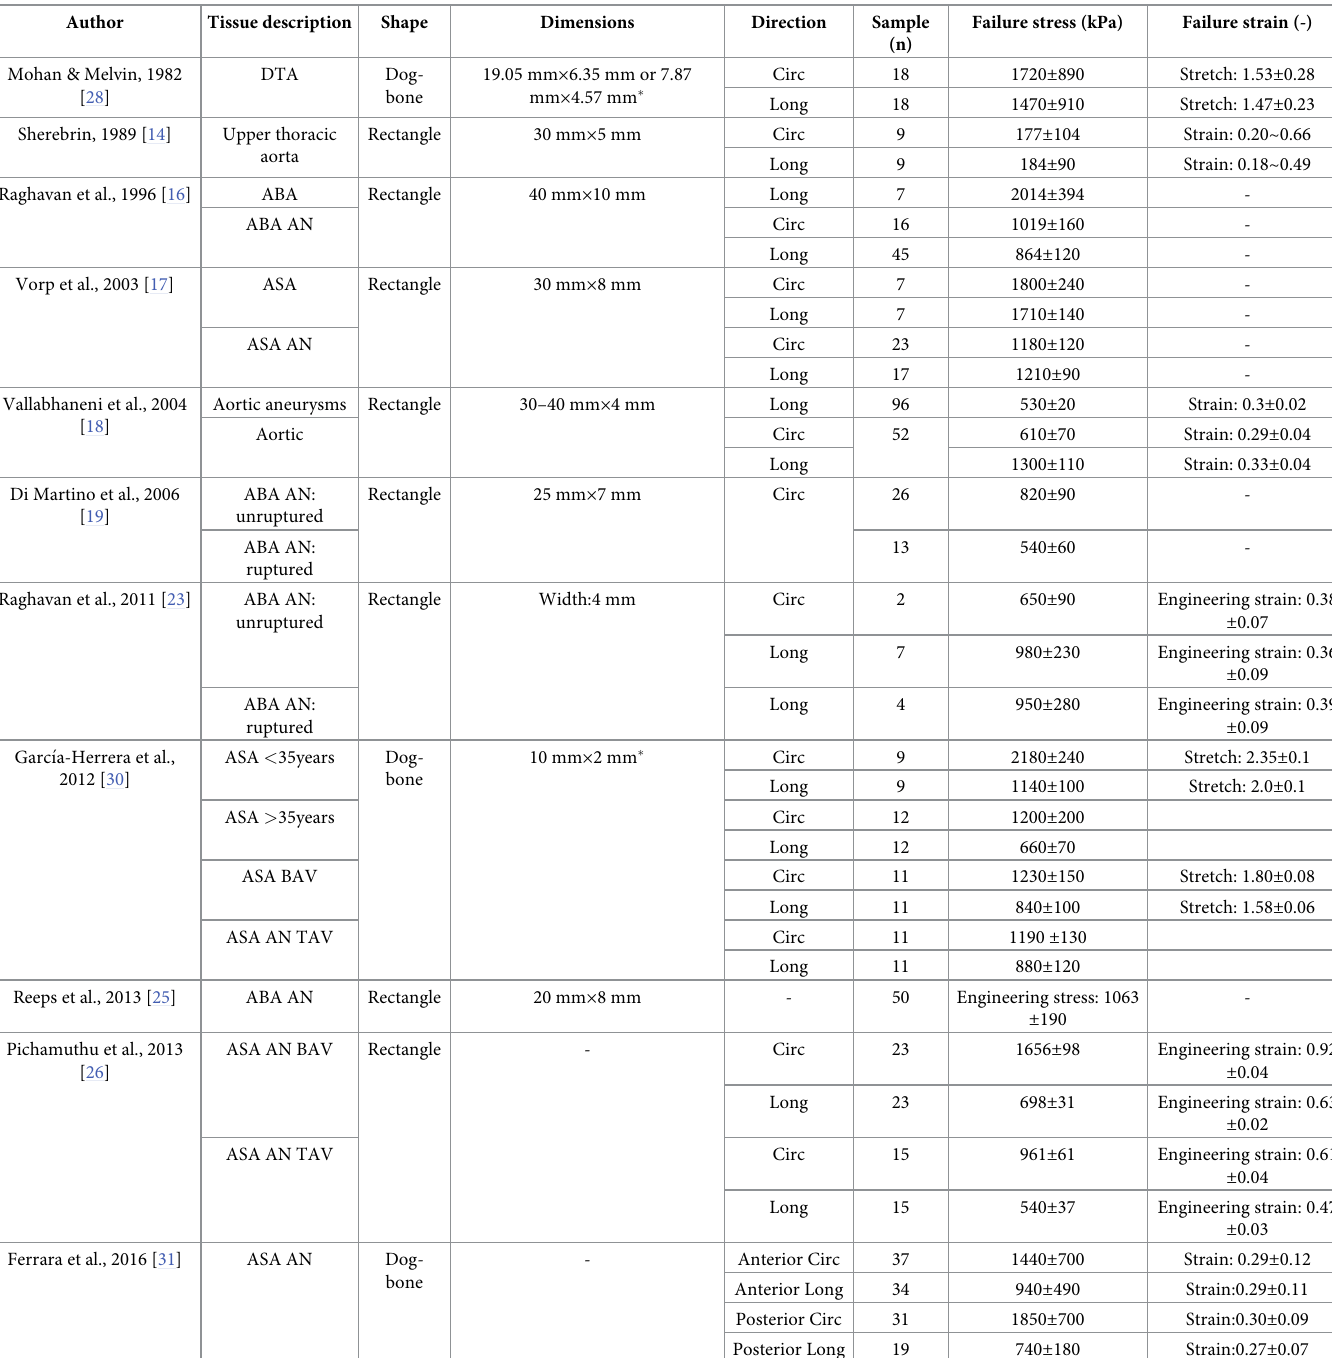
Table 1. Overview of uniaxial tensile test results on aorta full-thickness tests performed until